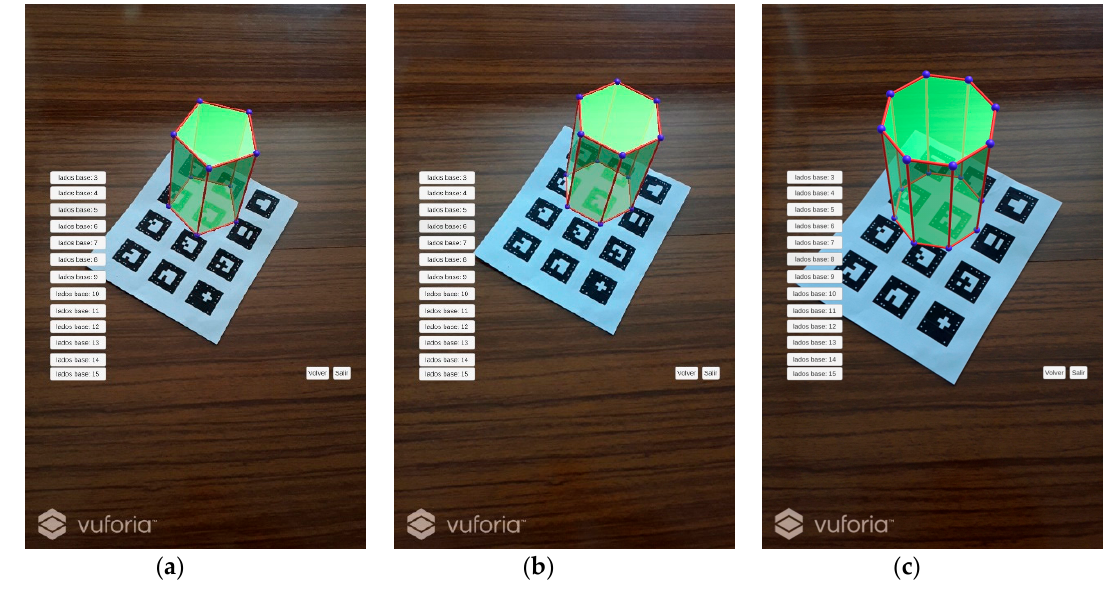
Figure 5. Images of regular prisms with AR application. ( a ) Prism with a pentagonal base; ( b ) Prism with a hexagonal base; ( c ) Prism with an octagonal base.